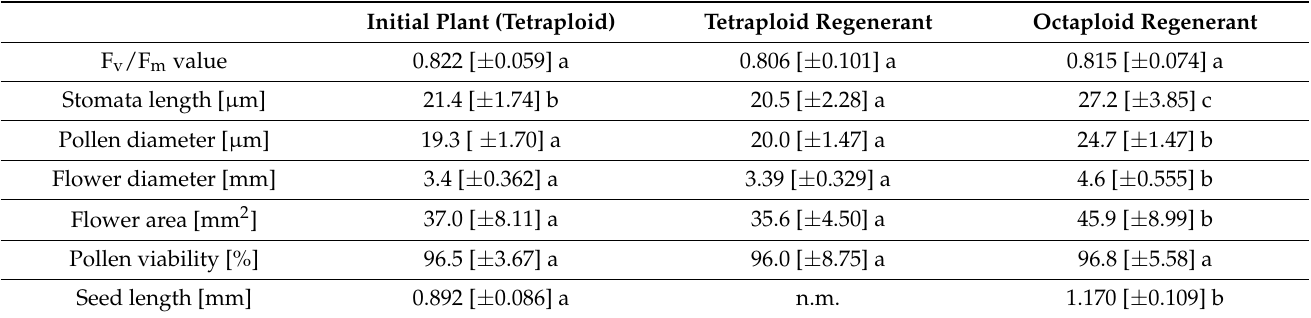
Table 3. Morpho-anatomical characteristics of initial tetraploids, tetraploid and octaploid regenerants of Arabidopsis arenosa grown in hydroponics. Different letters mean statistical differences ( p ≤ 0.05) with one-way ANOVA, followed by the Tukey HSD test between each dependent